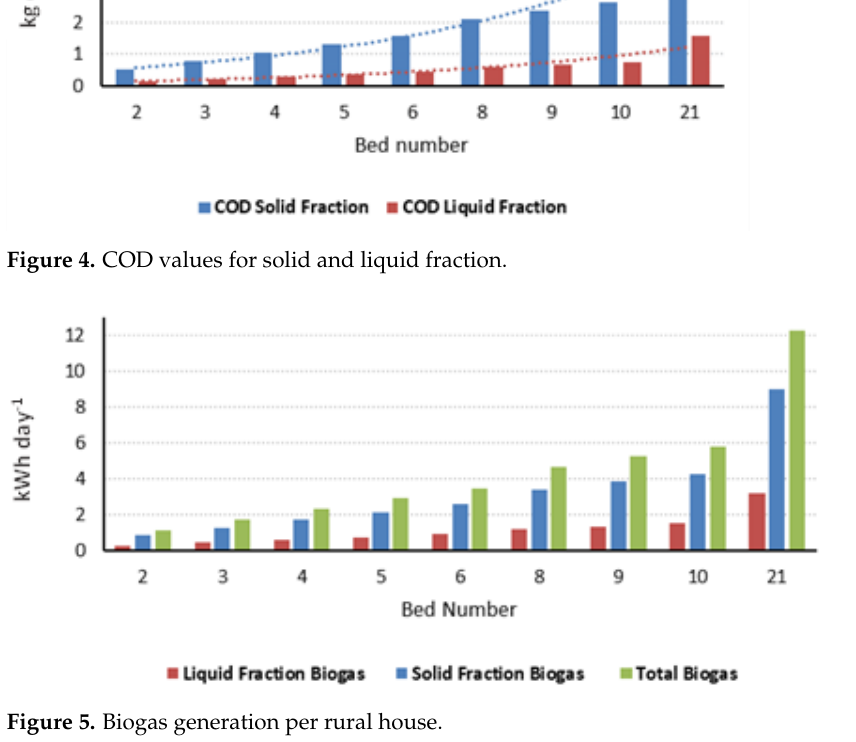
Figure 4. COD values for solid and liquid fraction.